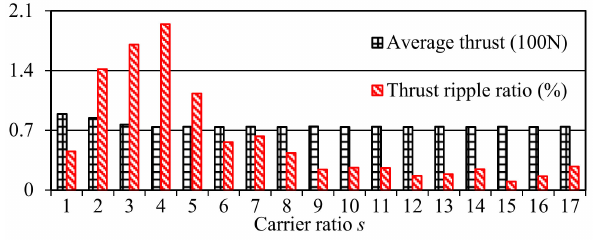
Figure 10. Thrust features versus the carrier ratio s for Array